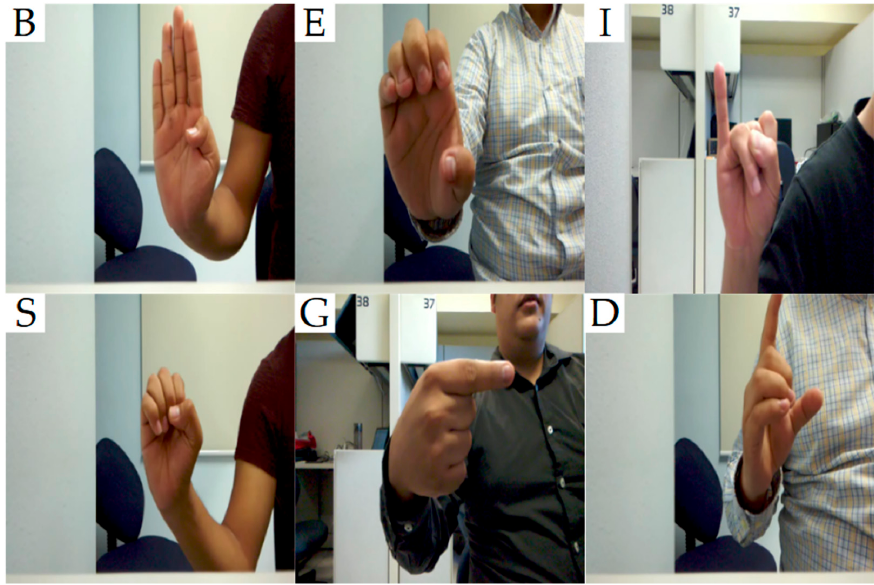
Figure 7. Samples of the signs B, E, I, S, G, and D of the testing dataset.